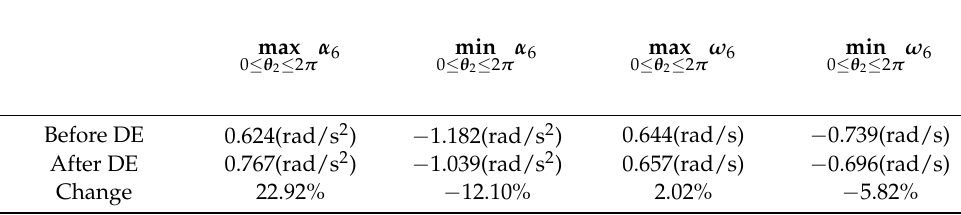
Table 5. α 6 and ω 6 of the passenger side output-link of CDLS before/after DE